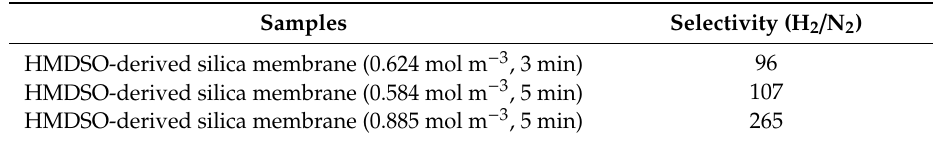
Table 2. Influence of precursor concentration and CVD time to the selectivity (H 2 / N 2 ) of the HMDSO-derived membranes deposited on asymmetric substrates.